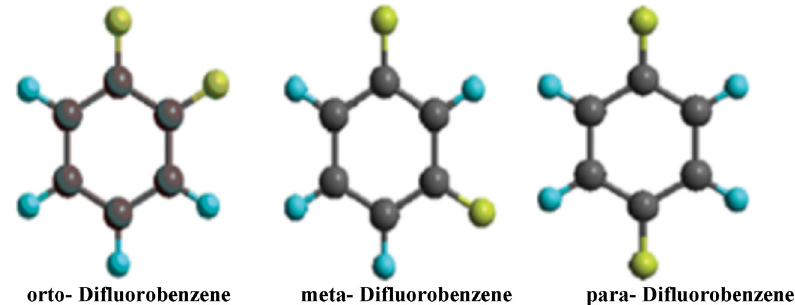
Figure 2: Structure of 1,2 di fl uorobenzene ( ortho ) , 1,3 di fl uorobenzene ( meta ) , and 1,4 di fl uorobenzene ( para ) molecules ( green color “ fl uorine, ” blue color “ hydrogen, ” and gray color “ carbon ” ) .